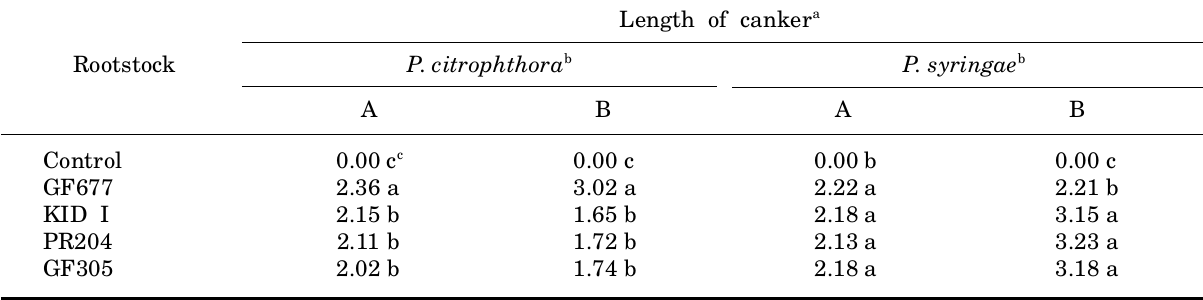
Table 2. Susceptibility to Phytophthora citrophthora and P. syringae as shown by canker length on four peach rootstocks tested by excised stem pieces.